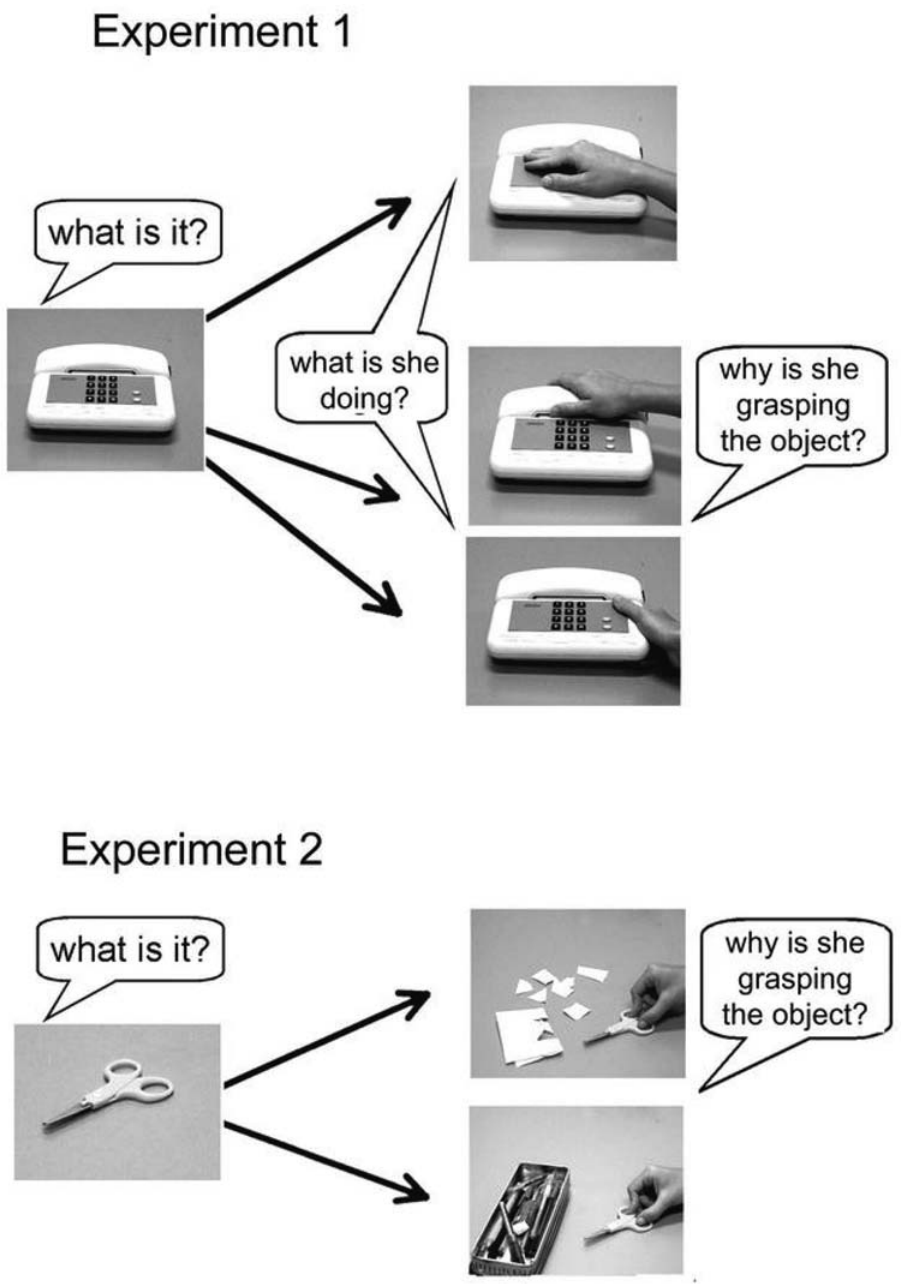
Figure 1. Experimental design of the two experiments. Examples of stimuli employed and the relative questions are shown.